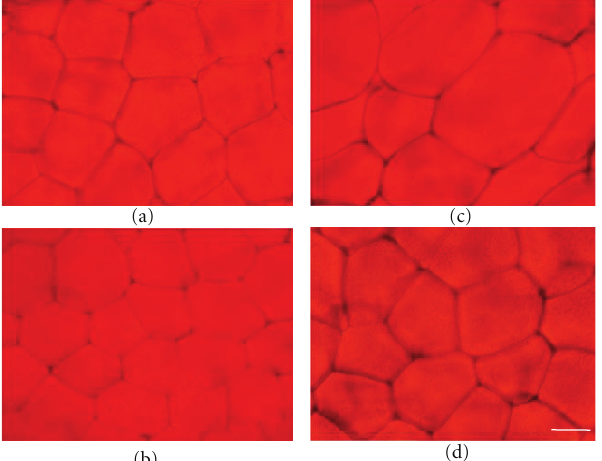
Figure 7: Transverse sections of the epididymal white adipose tissue were stained with Sudan red. (a) LC group; (b) LH group; (c) OC group; (d) OH group. Bar = 50 μ